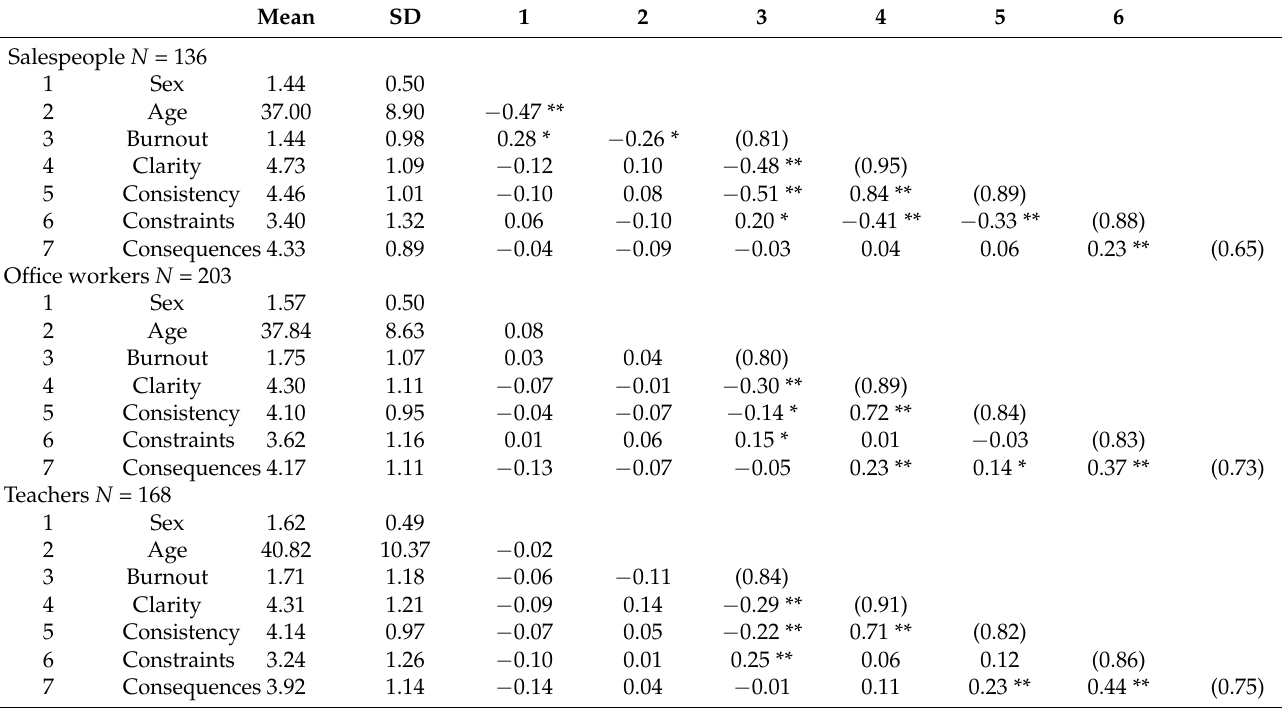
Table 1. Descriptives (mean, standard deviation), reliabilities (in brackets on the diagonal), and correlation